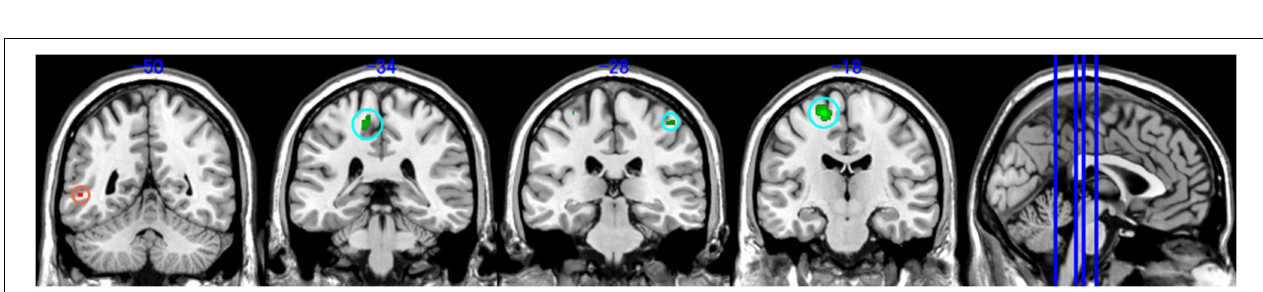
FIGURE 1 | Brain areas with significant volume reduction of gray matter (GM). Green map: Control vs. PoTS, Red map: PoTS vs. Control. From left panel ( − 9): left putamen, ( − 7): left insula and bilateral putamen, ( − 6): left insula, (8): right cingulate gyrus.